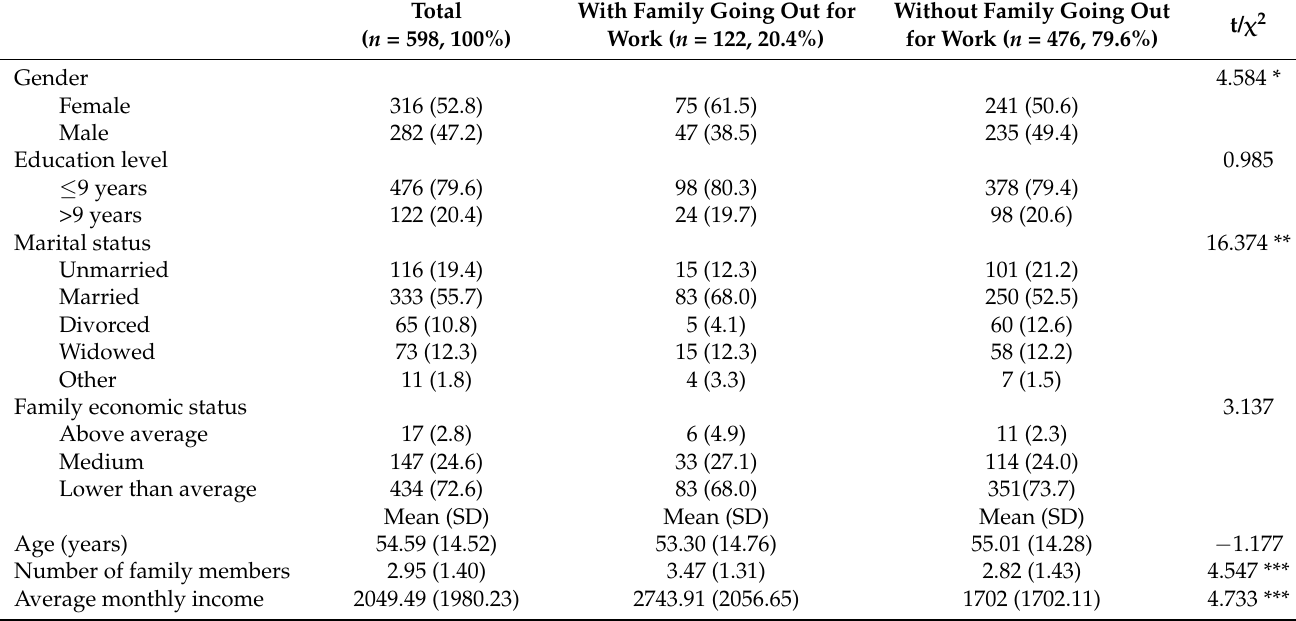
Table 1. Demographic characteristics of participants with and without family going out for